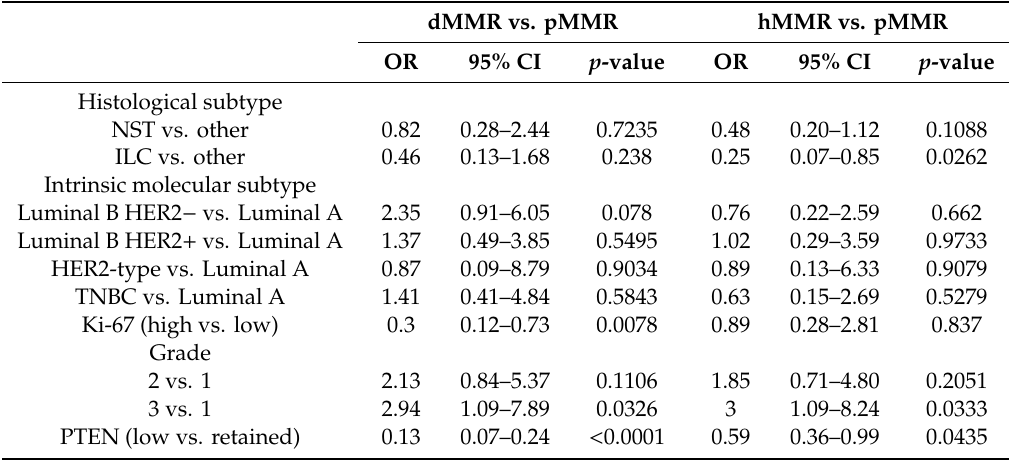
Table 5. Multivariable analysis showing the association of selected clinicopathologic characteristics and PTEN expression with MMR status. NST, invasive carcinoma of no special type (ductal); ILC, invasive lobular carcinoma; TNBC, triple-negative breast cancer; OR, odds ratio; CI, confidence interval; dMMR, mismatch repair-deficient; pMMR, mismatch repair proficient; hMMR, mismatch repair